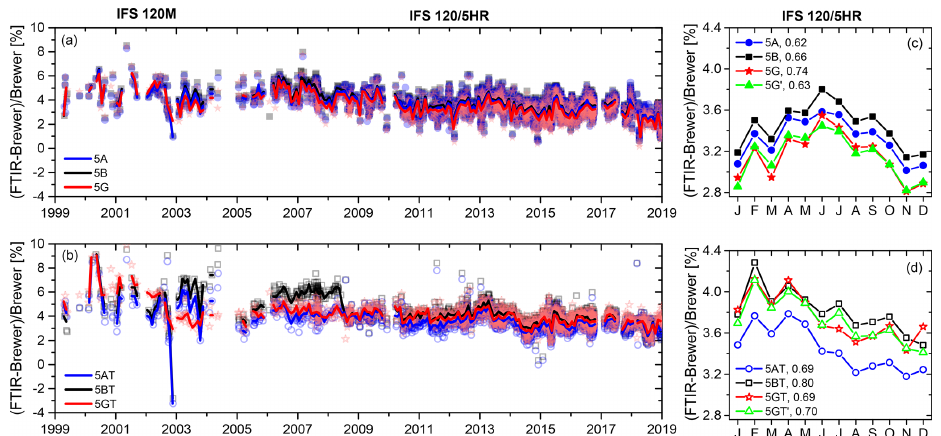
Figure 6. Summary of Brewer–FTIR comparison from 1999 to 2018. (a) RD time series (O 3 TC FTIR –O 3 TC Brewer , in %) for the set-ups 5A, 5B, and 5G. Panel (b) is the same as (a) but for the set-ups 5AT, 5BT, and 5GT. (c) Averaged annual cycles of the RD for the 2009–2018 period for the set-ups 5A, 5B, and 5E. Panel (d) is the same as (c) but for the set-ups 5AT, 5BT, and 5GT. The averaged annual cycles for the ILS strategies 5G (cid:48) and 5GT (cid:48) have also been included in (c) and (d) , respectively. The solid lines in (a) and (b) correspond to the monthly median values. The legend in (c) and (d) shows the seasonal amplitude of each cycle.